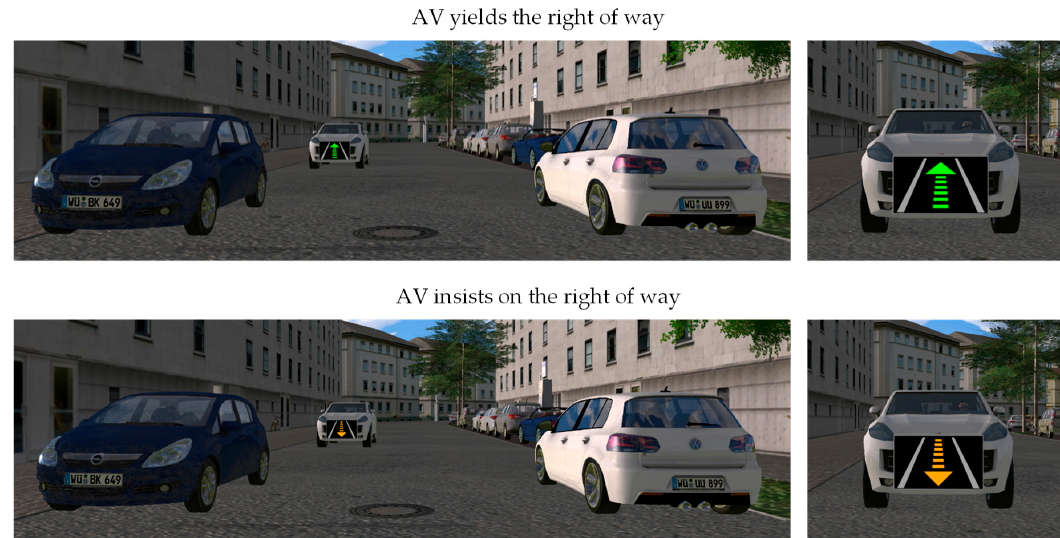
Figure 10. External HMI used in the study. In the upper part of the picture the AV indicates to yield the right of way to the human driver. In the lower part the AV communicates to insist on the right of way. The illustrated scenario is the road bottleneck narrowed on both sides of the road [30].